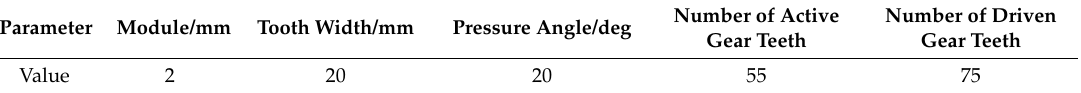
Figure 10. Structure sketch of the test bed. Table 1. The parameters of experimental gearbox. AC, alternating current.